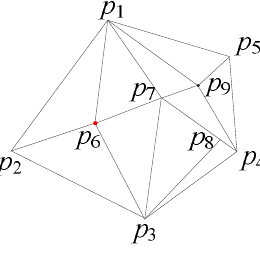
Figure 10. Triangular meshes.